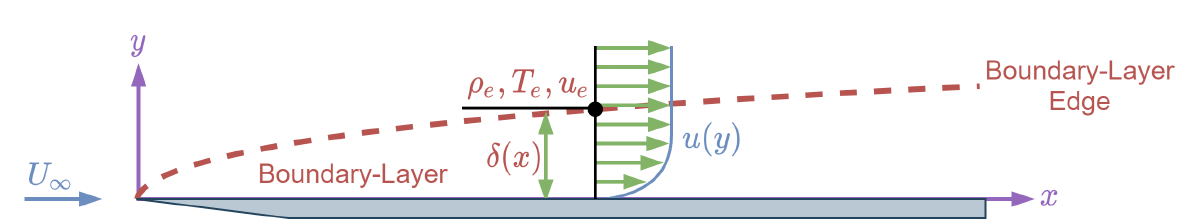
Figure 2. Schematic description of the flow over a flat plate. The red dashed line corresponds to boundary-layer edge. The boundary-layer velocity profile is illustrated with a blue line. The black dot corresponds to the boundary-layer edge at that station. The density, temperature, and velocity at the boundary-layer edge are ρ e , T e , and u e , respectively. The boundary-layer thickness is defined with δ ( x ) , which is the function of x